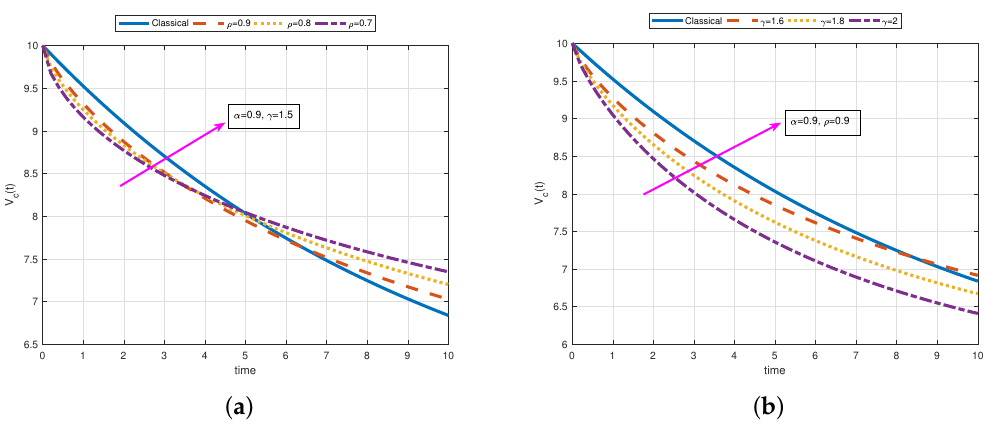
Figure 2. The figure ( a ) corresponds to the function V c ( t ) with constant source for different values of α , ρ , and γ in order to show the effect of α and γ , and also the figure ( b ) is plotted to show the effect of α and ρ when R = 1 Ω , C = 10 F, e 0 = 5 V, and V c ( 0 ) = 10.